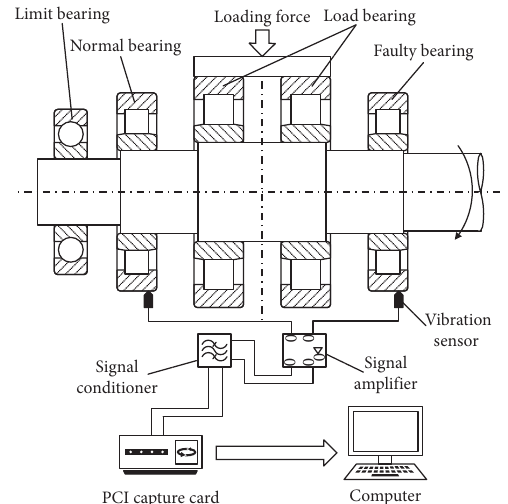
Figure 9: Schematic diagram of the acquisition system. Table 1: Test schedule.